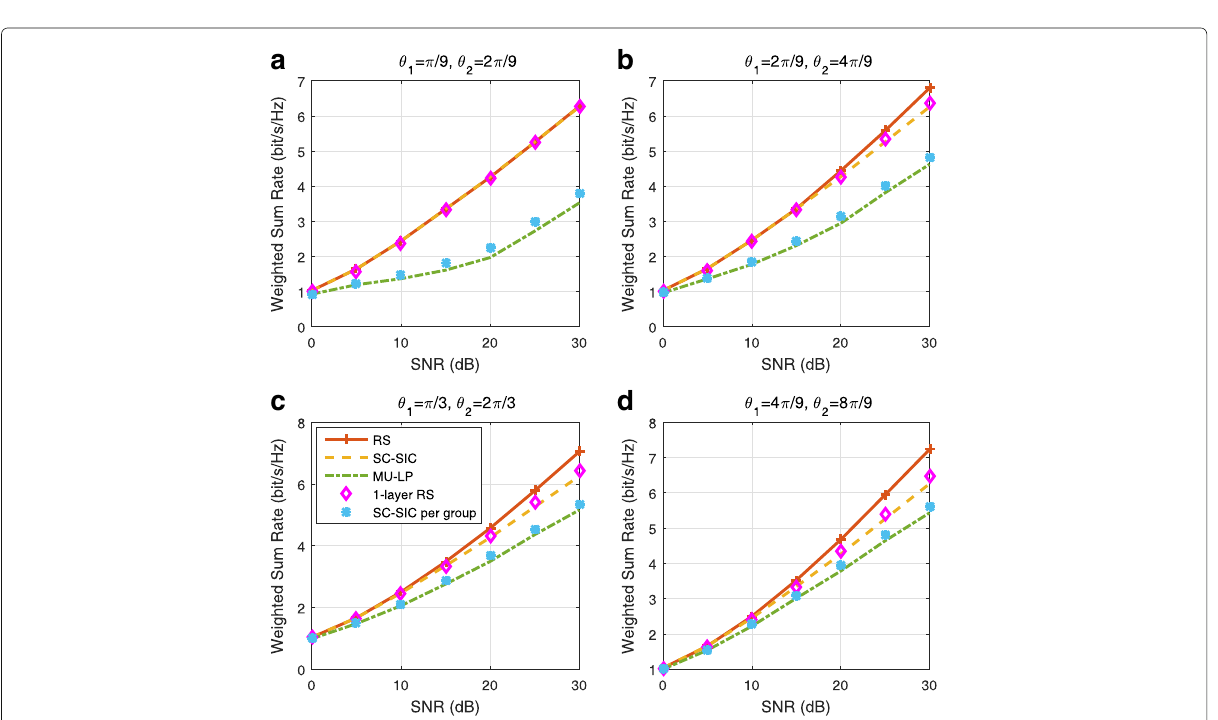
Fig. 57 Weightedsumrateversus SNR comparison of different strategies for overloaded three-user deployment with imperfect CSIT, γ 1 = 1, γ 2 = 0.3, u 1 = 0.6, u 2 = 0.3, u 3 = 0.1, N t = 2, r th = [0.02,0.08,0.19,0.3,0.4,0.4,0.4] bit/s/Hz. a θ 1 = π/ 9, θ 2 = 2 π/ 9. b θ 1 = 2 π/ 9, θ 2 = 4 π/ 9. c θ 1 = π/ 3, θ 2 = 2 π/ 3. d θ 1 = 4 π/ 9, θ 2 = 8 π/